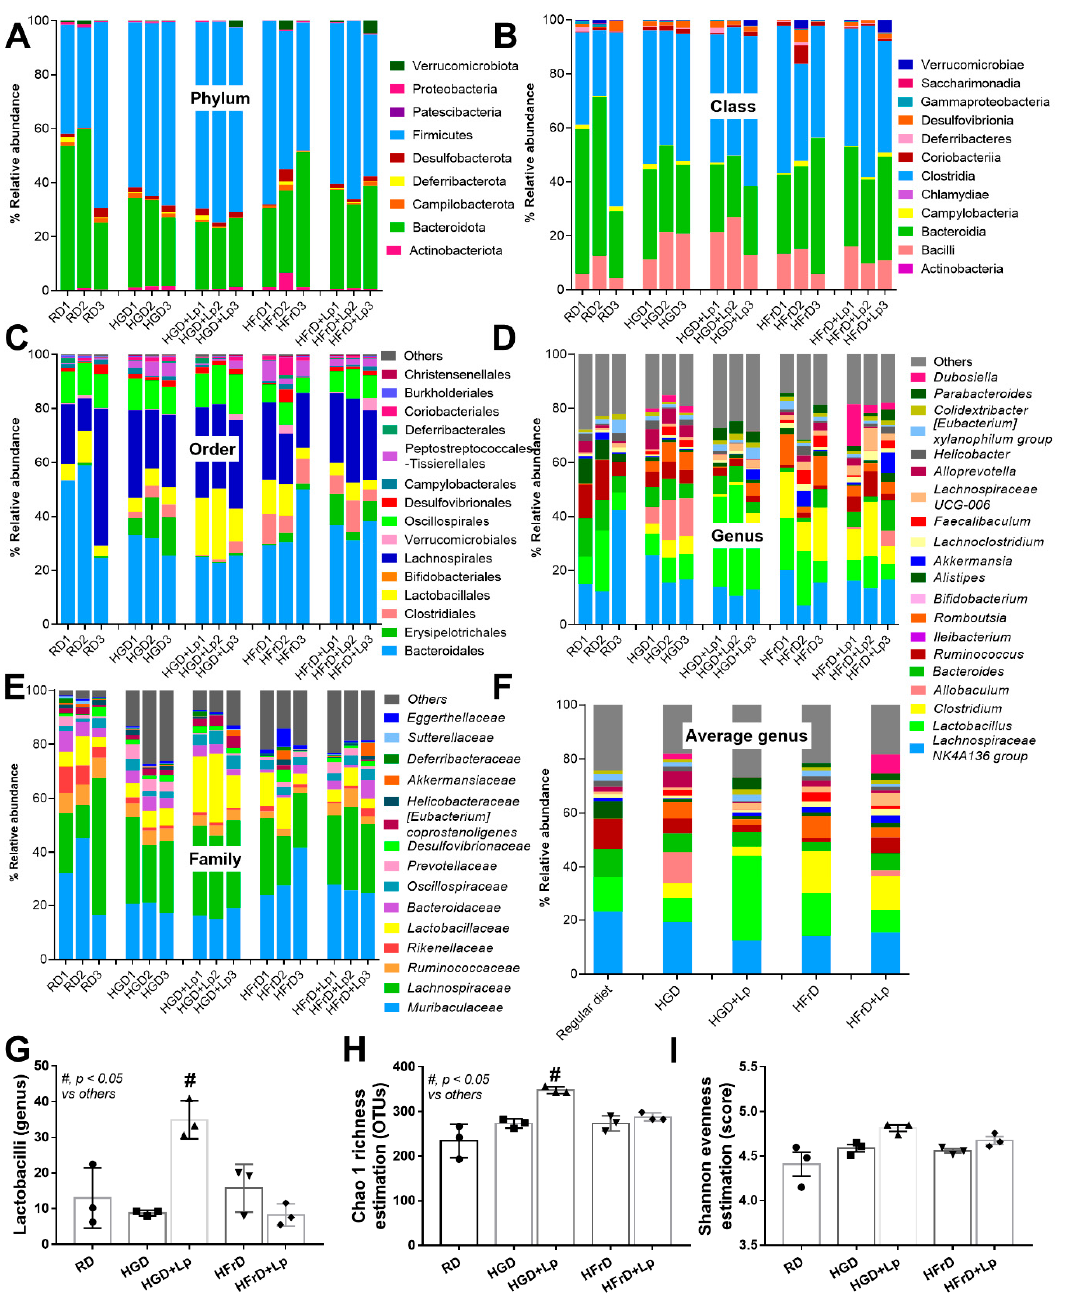
Figure 4. Gut microbiota analysis from feces of mice with regular diet (RD) or high-glucose diet (HGD) or high-fructose diet (HFrD) with or without Lactiplantibacillus plantarum (Lp) as determined by the relative abundance of bacterial diversity at the phylum, class, order, family, genus, and average at genus level ( A – F ), the graph presentation of Lactobacilli (in genus level) ( G ), and the alpha diversity are demonstrated by estimation of Chao 1 richness and Shannon evenness analysis ( H , I ) are demonstrated.